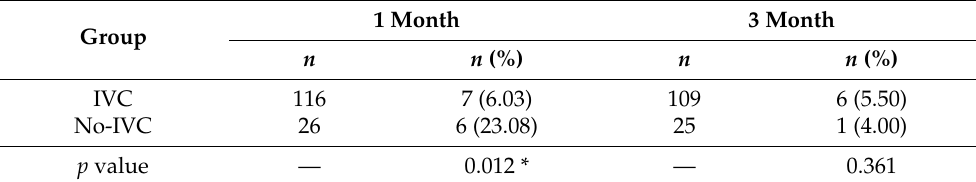
Table 5. Comparison of postoperative rebleeding rate between the two